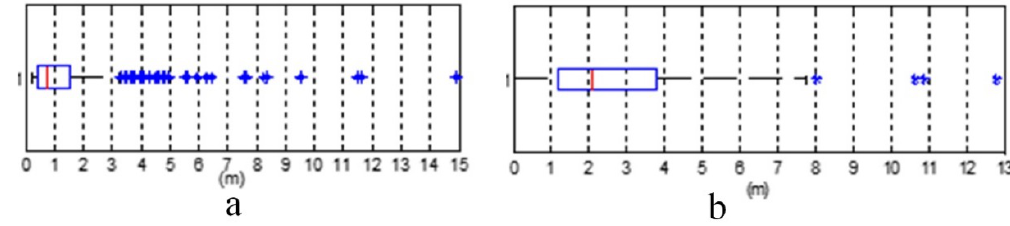
Figure 10. Boxplot of LoDs for the building polygons from 1:2K (left) and 1:5K (right) maps.